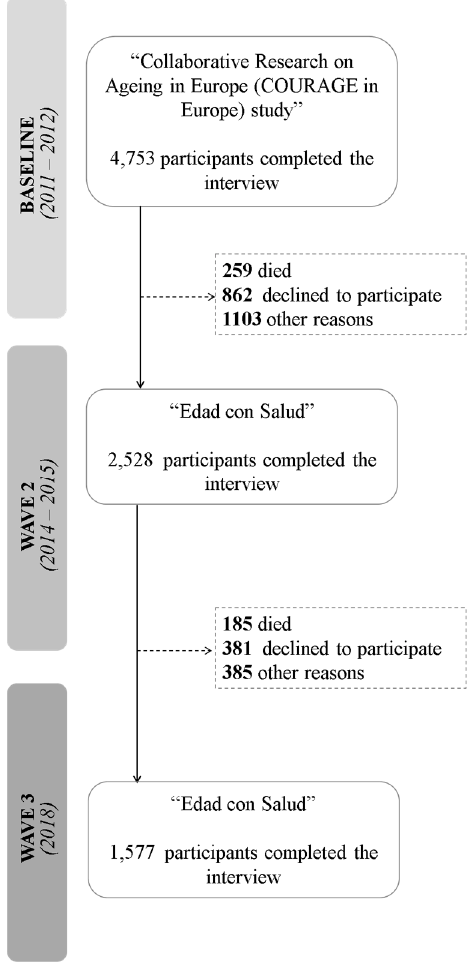
Figure 1. Flow-chart of the study population.